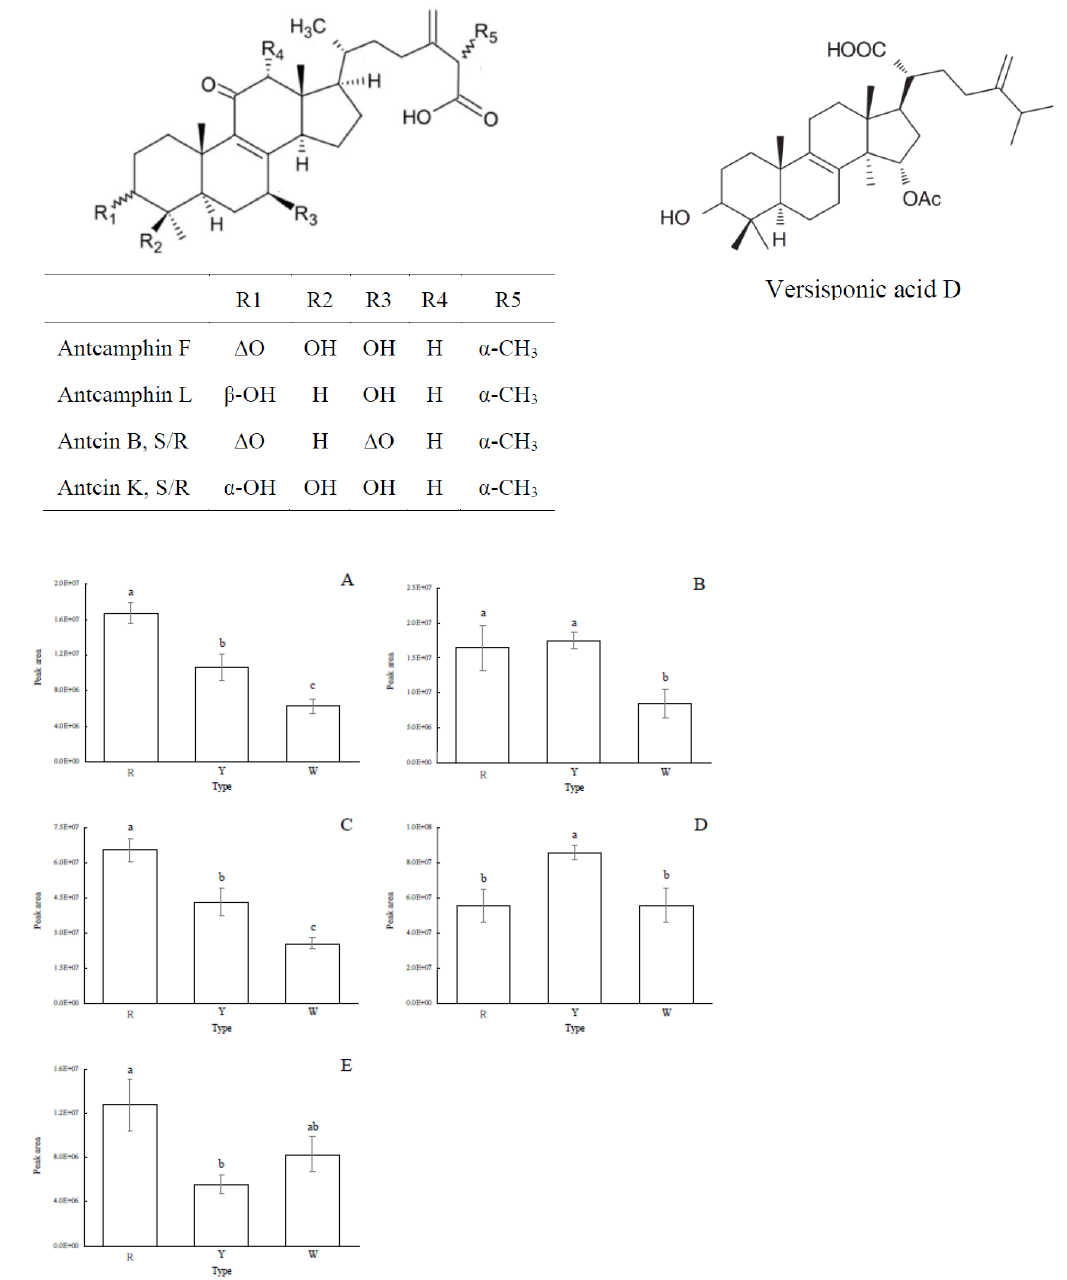
Figure 4. Differences in the relative content of the compounds with known structure in different